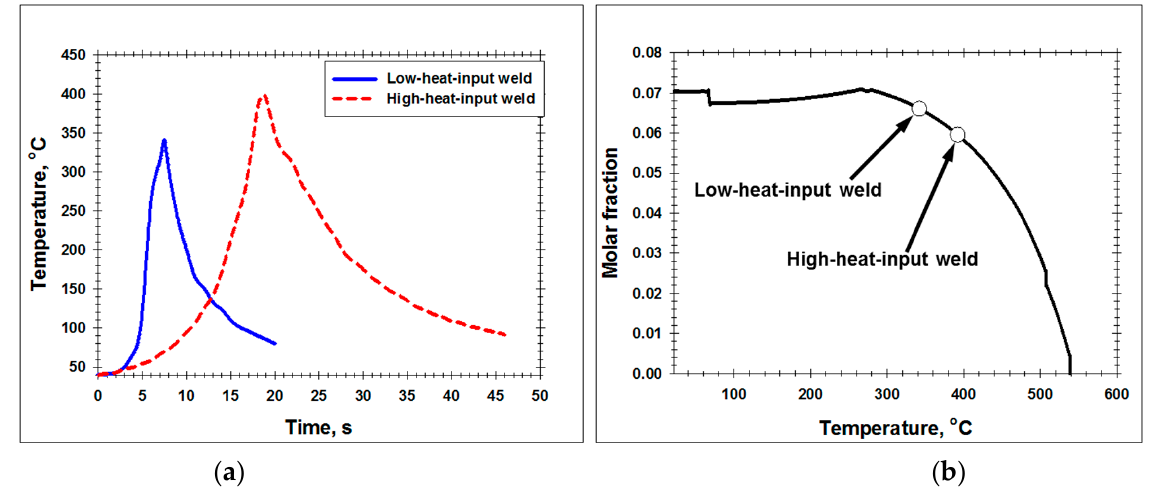
Figure 3. ( a ) Typical thermal cycles measured during FSW and ( b ) ThermoCalc prediction of the temperature dependence of the molar fraction of Al 2 Cu (i.e., θ -) phase.